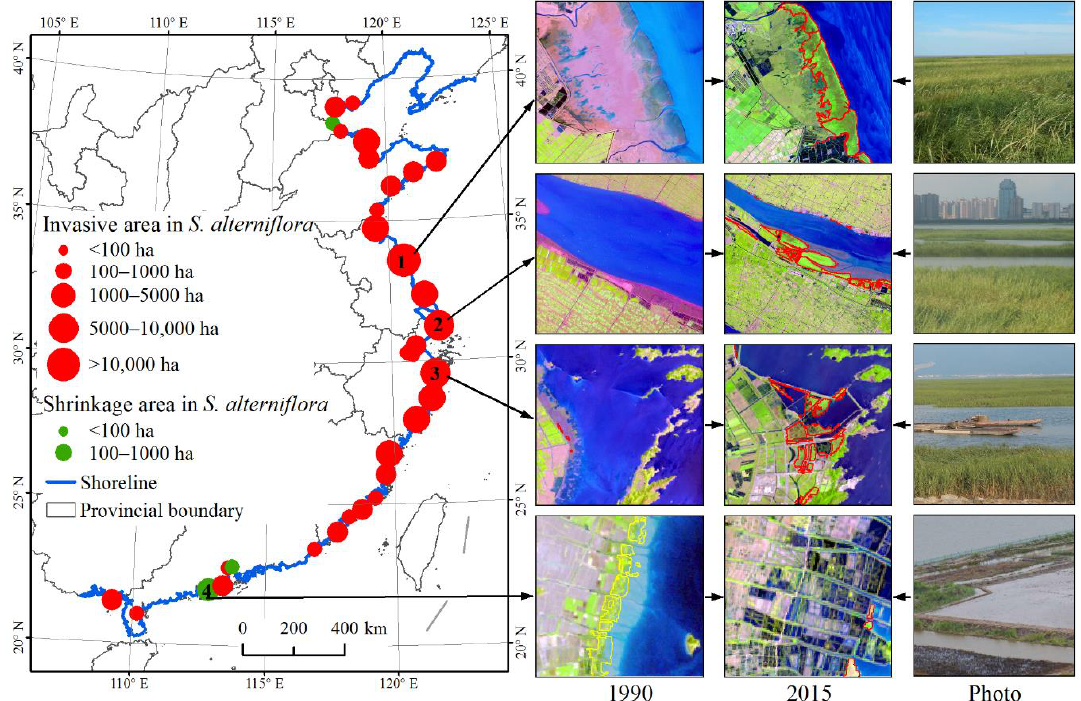
Figure 4. Areal changes of S. alterniflora between 1990 and 2015. The statistic of S. alterniflora area was obtained at the scale of city. Number 1 represents the location in Yancheng of Jiangsu; number 2 represents the location in Chongming of Shanghai; number 3 represents the location in Ningbo of Zhejiang; and number 4 represents the location in Jiangmen of Guangdong. Satellite images (composited from bands: red, green, and blue) provide examples for notable expansion and shrinkage of S. alterniflora ; those corresponding photos were taken in 2015.